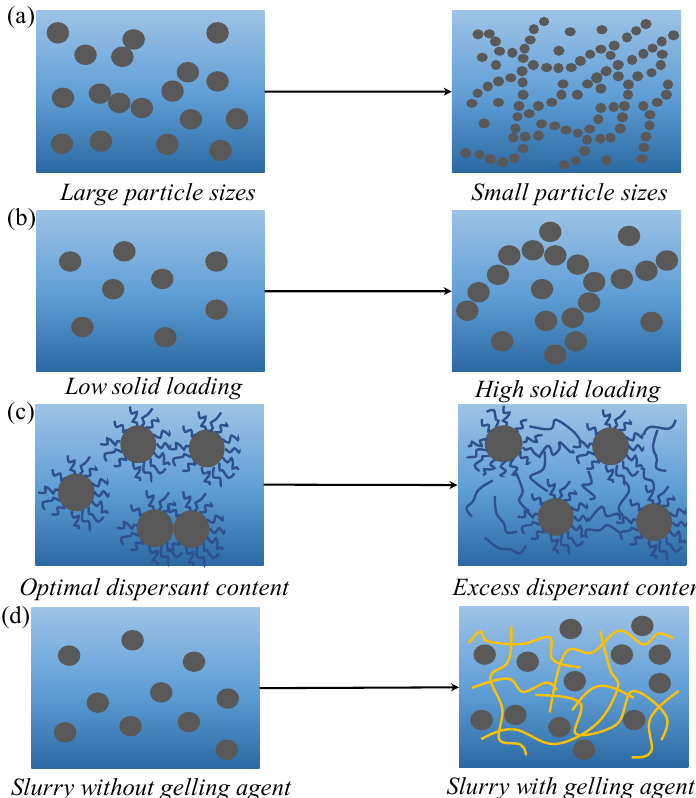
Figure 12. The evolution of the structure inside slurry with the varieties of ( a ) particle size, ( b) solid loading, ( c ) dispersant content and ( d ) gelling agent content. loading, ( c ) dispersant content and ( d ) gelling agent content.